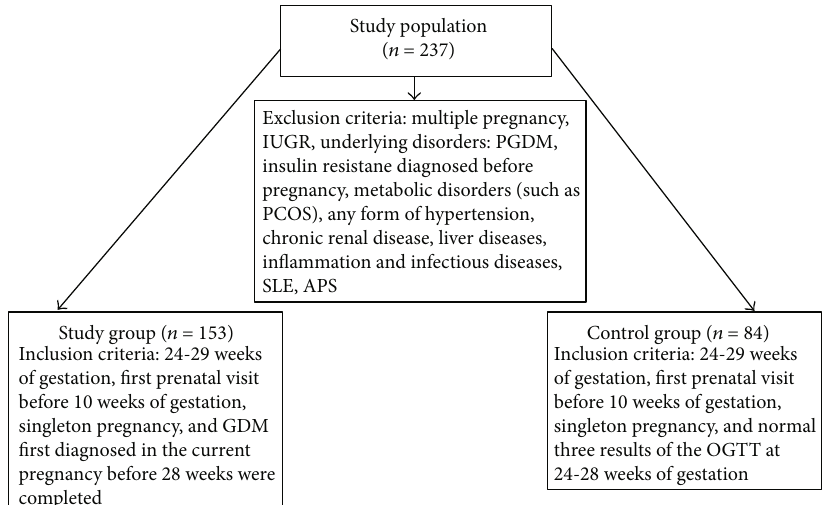
Figure 1: Flow chart of study